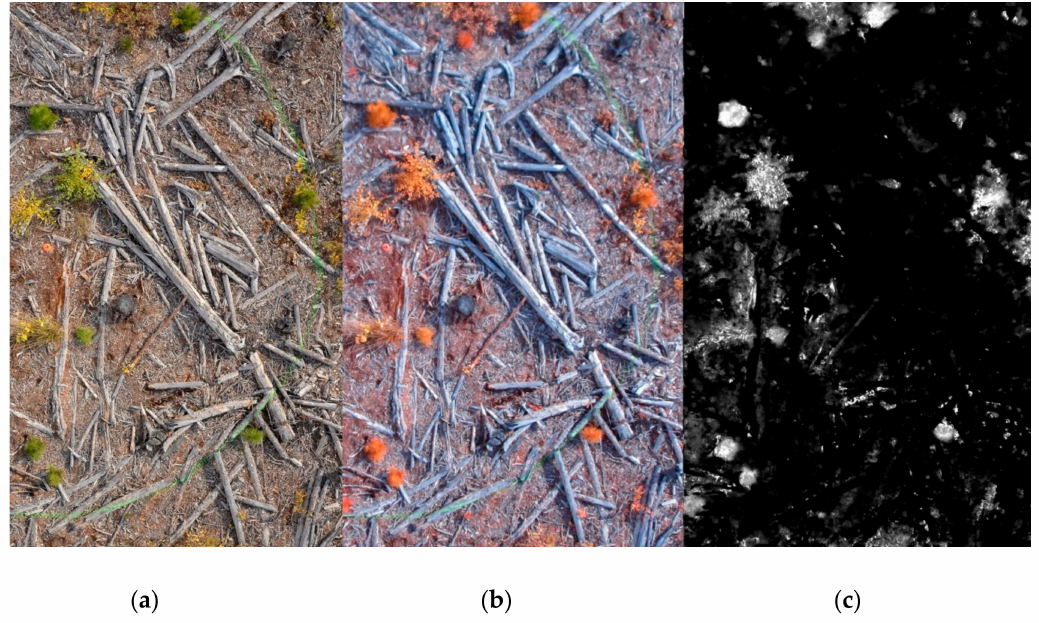
Figure 4. Detail of the UAV image from a sample plot. Left to right: ( a ) red, green, and blue (RGB) (3 mm spatial resolution), ( b ) red-edge (RE) (5 mm spatial resolution), and ( c ) red ratio/blue ratio (from the RGB